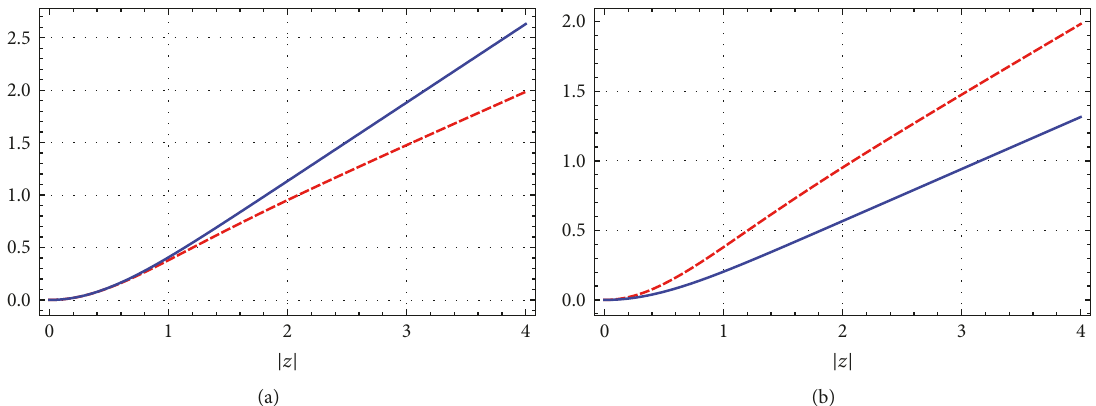
Figure 7: (a) The variances of the input |𝑧 퐸 ,0⟩ and output BS |𝑧 퐸 , 0⟩ signals of a 50 :50 beam splitter, red-dashed, and blue, respectively, with |𝑧 ⟩ (1,1) coherent state (34). (b) The variances of the signals at the horizontal and vertical output ports are equal (blue) and shorter 퐸 푁 the su than the variance of the input |𝑧 퐸 ,0⟩ (red-dashed) for any |𝑧| ̸= 0 .